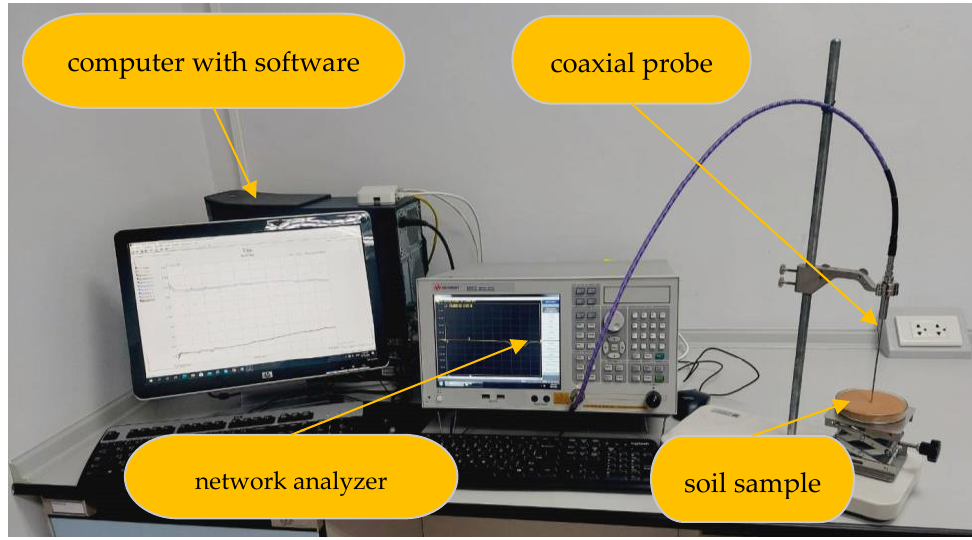
Figure 3. Experimental setup of dielectric properties measurement.